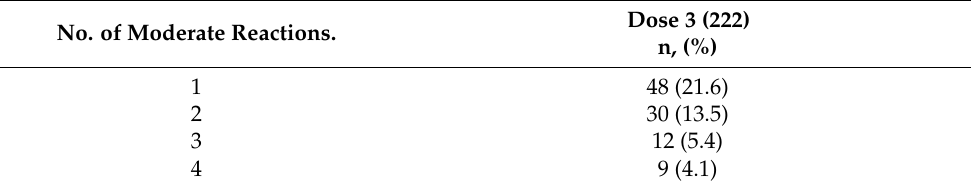
Table 3. Prevalence of reporting of one or more moderate adverse reactions interfering with activities following the third vaccination dose, among subjects without severe